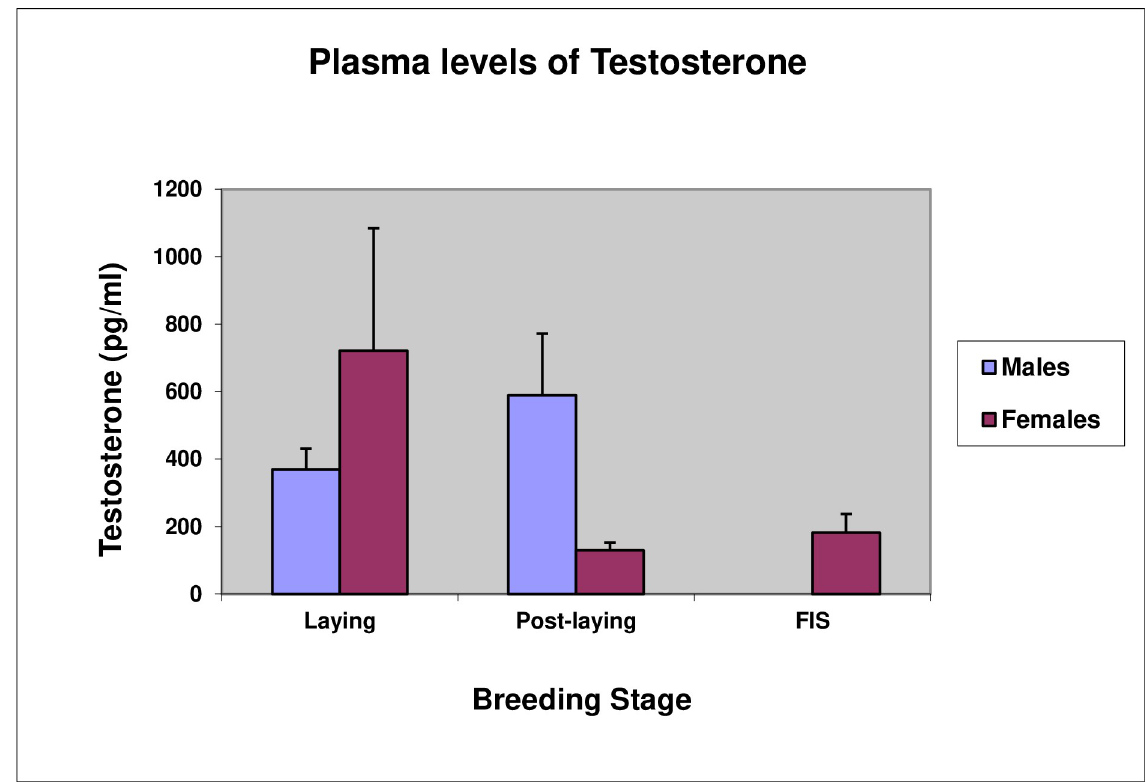
Fig 14. Mean ( ± se) plasma levels of testosterone (pg/ml) during the laying, post-laying, and first incubation spell (FIS).